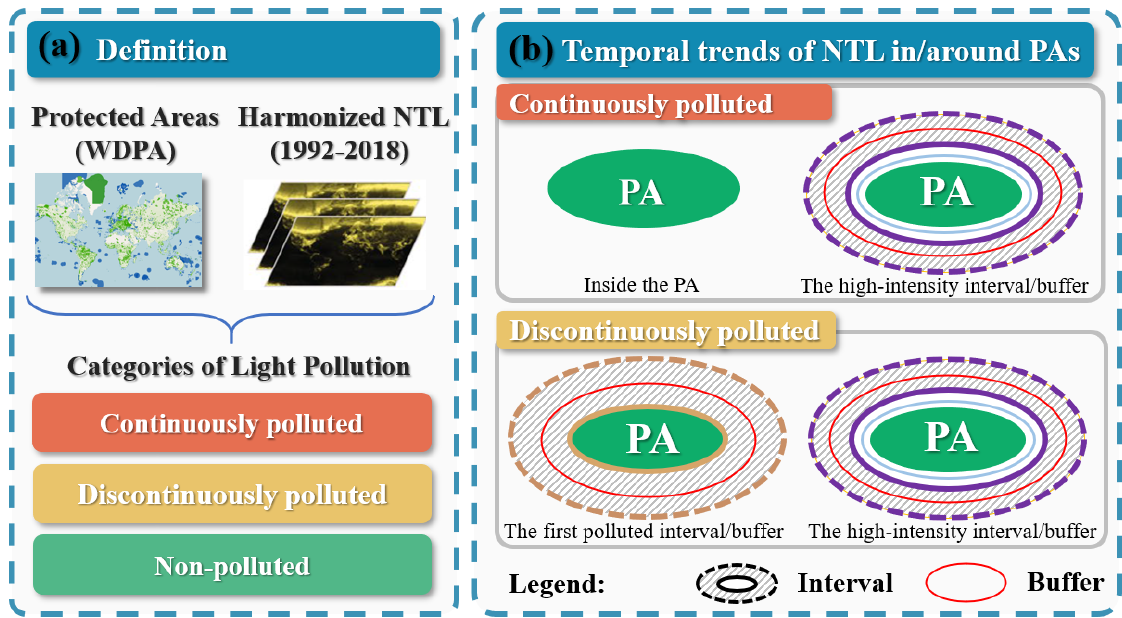
Figure 1. The proposed analyses framework of light pollution in global PAs by combining different light pollution categories ( a ) and the temporal trend of NTL in polluted PAs ( b ). Note: PAs are simplified as ellipses for illustration.